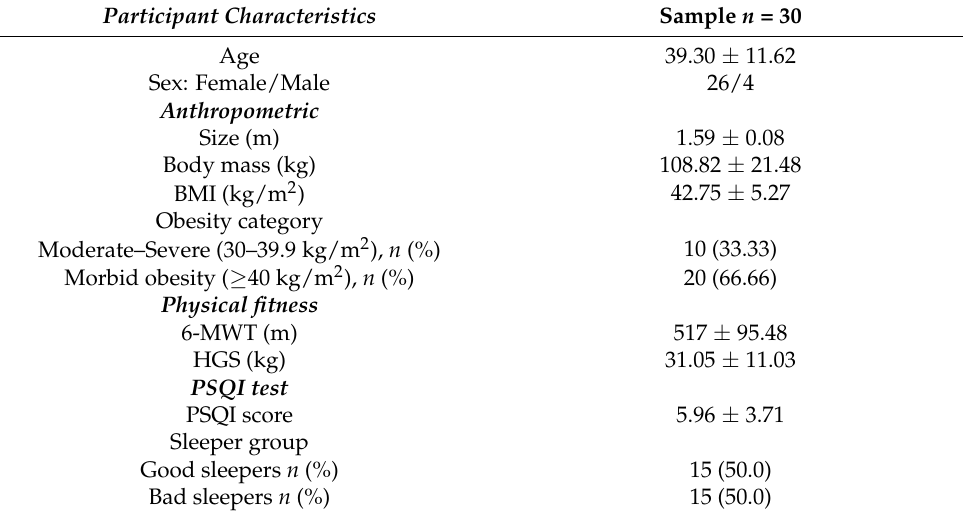
Table 1. Shows the characteristics of sample study. Participant